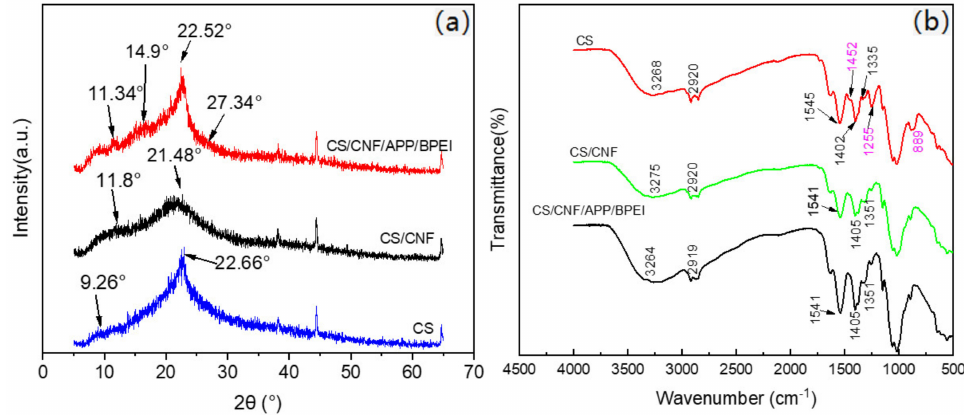
Figure 3. ( a ) XRD and ( b ) FTIR spectrums of the different CS-based composite